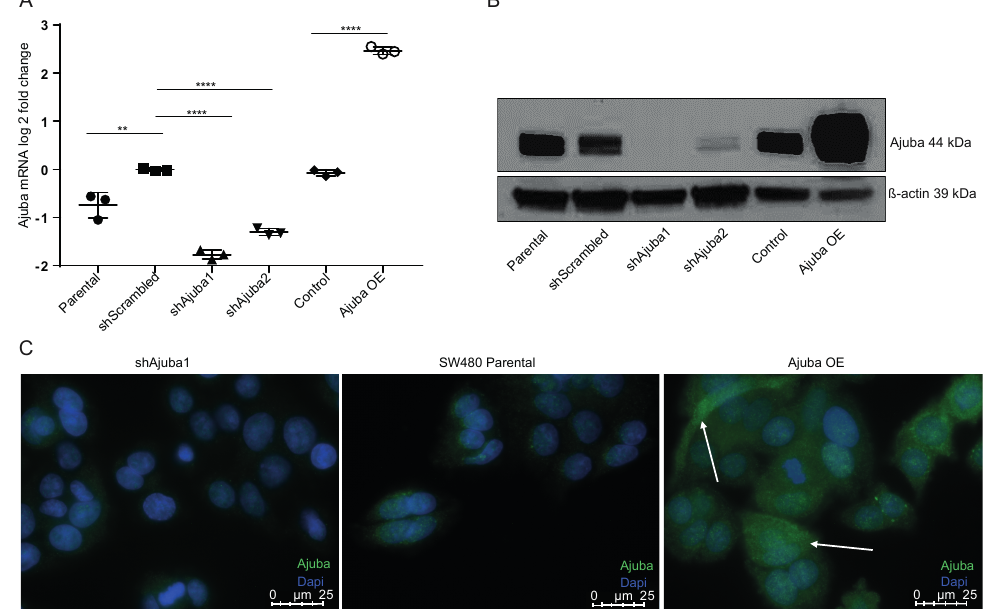
Figure 2. Ajuba was e ffi ciently knocked down and overexpressed using lentiviral transduction. ( A ) Ajuba mRNA expression level measured by RT-qPCR in colon cancer cell line SW480 where Ajuba has been previously transfected with lentivirus ( n = 3, one representative transfection shown). ShScrambled vs. Parental = 0.0083, shScrambled vs. shAjuba1 ≤ 0.0001, shScrambled vs. shAjuba2 ≤ 0.0001, Control vs. Ajuba OE ≤ 0.0001. ( B ) Western blot analysis of Ajuba protein in colon cancer cell lines where Ajuba has been KD and OE. ( C ) Immunofluorescence pictures of SW480 CRC cell line shAjuba1, parental and Ajuba OE stained for Ajuba and DAPI. The upper arrow indicates a cell with elongated morphology and the lower arrow indicates a cell that is ready for cytokinesis (40 × images). For all analyses NS denotes p > 0.05, * p < 0.05, ** p < 0.01, *** p < 0.001, **** p <